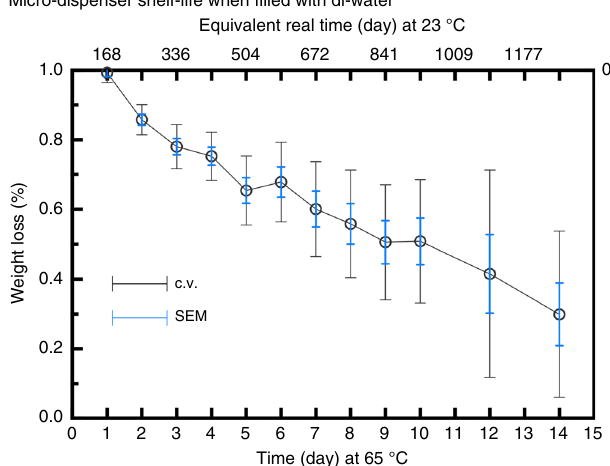
Fig. 2 The shelf-life of micro-dispenser; the shelf-life of 7 different micro- dispensers containing an average volume of 475 μ l di-water, where the fl ask is made of glass and the membrane of neoprene, the error bars show the standard deviation of the mean and coef fi cient of variation